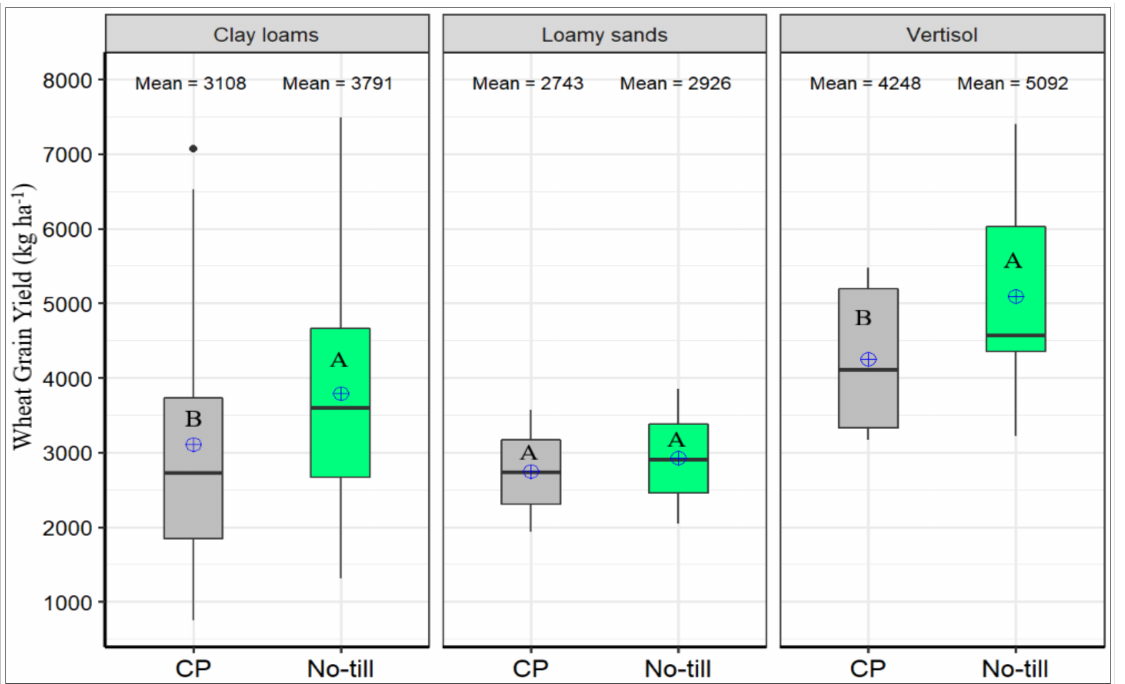
Figure 4. Wheat grain yield from conventional practice and no-till (NT) treatments from sites under clay-loam, loamy sands and vertisol across growing seasons. Means with different letters (A, B) under each soil type are significantly different at p <